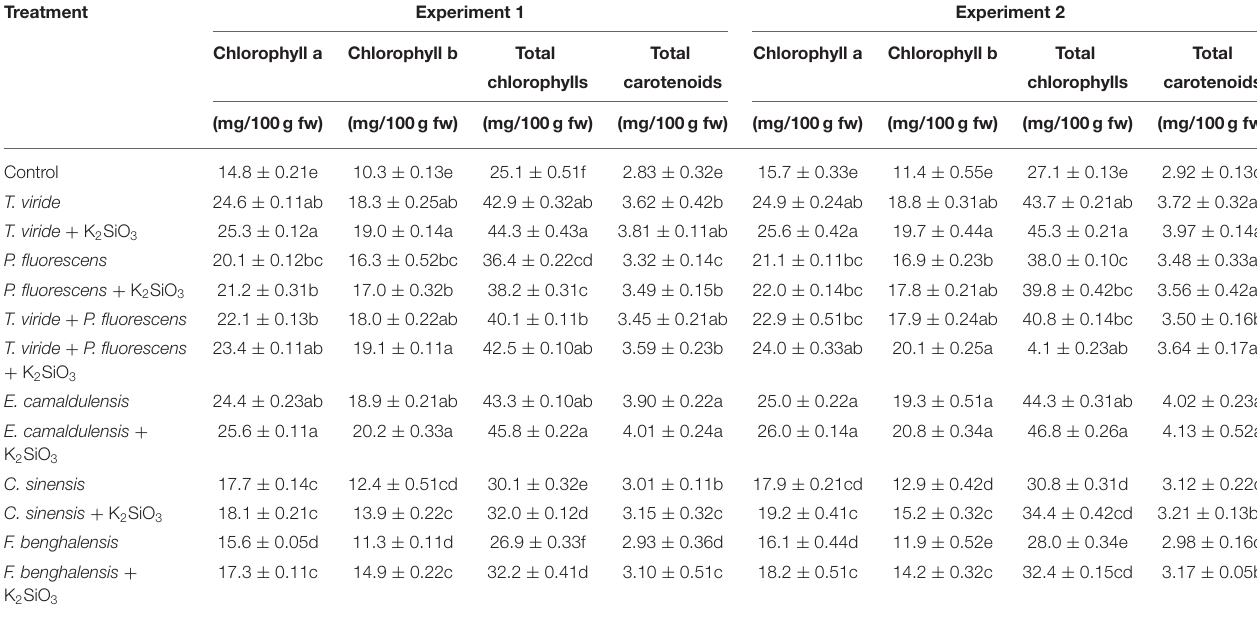
TABLE 2 | Effect of plant extracts, microbial inoculations, and potassium silicates biostimulants, on photosynthetic pigments content of leaves in the second experiment.